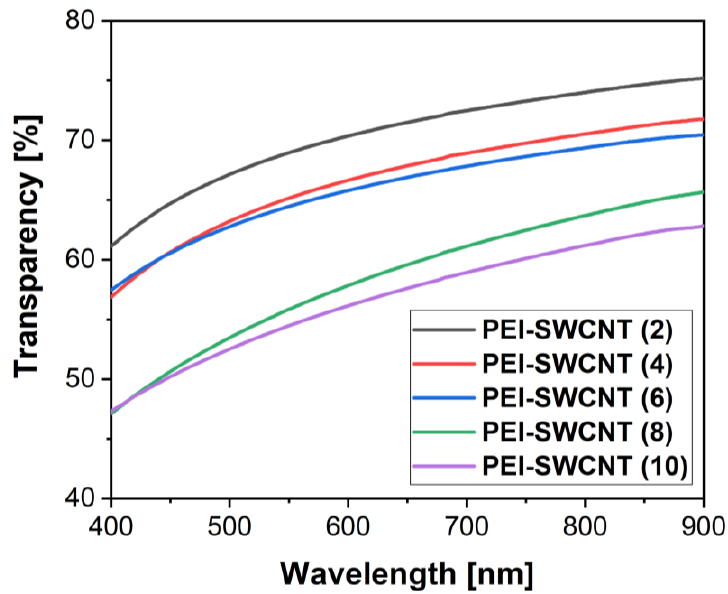
Figure 6. The transmittance of PEI+SWCNT with up to 10 bilayers in the visible spectral range. The FTIR spectra of the samples showed a gradual decrease in transparency in the IR detector working range with the number of deposited layers. Given that the transparency of the glass substrate was around 70%, the film with six deposited bilayers transmitted over 50% of the IR waves. We consider that further deposition of the material would not be beneficial for applications of the film; thus, we conclude that between four and six bilayers is an optimal number regarding optical properties. FTIR spectra for all samples are presented in Figure 7.